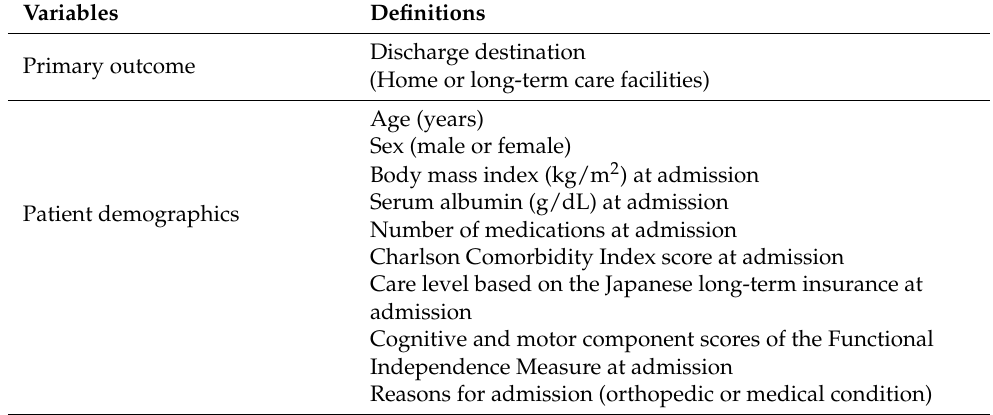
Table 1. Definitions of the